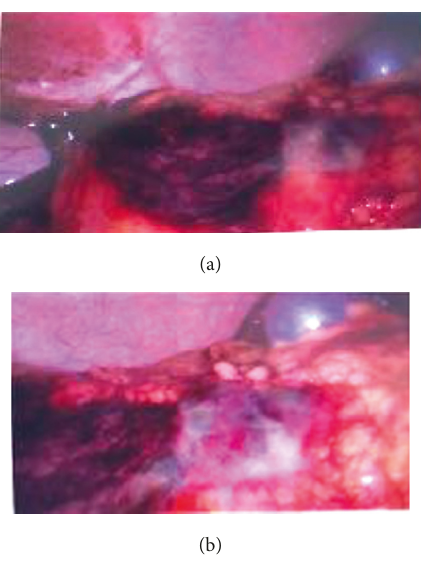
Figure 1: (a, b) Patchy areas of necrosis and pseudomembrane on the omentum. A look at the upper left side of (a) showed the area of attachment of the omentum with serosanguinous fluid seen at the lower end.